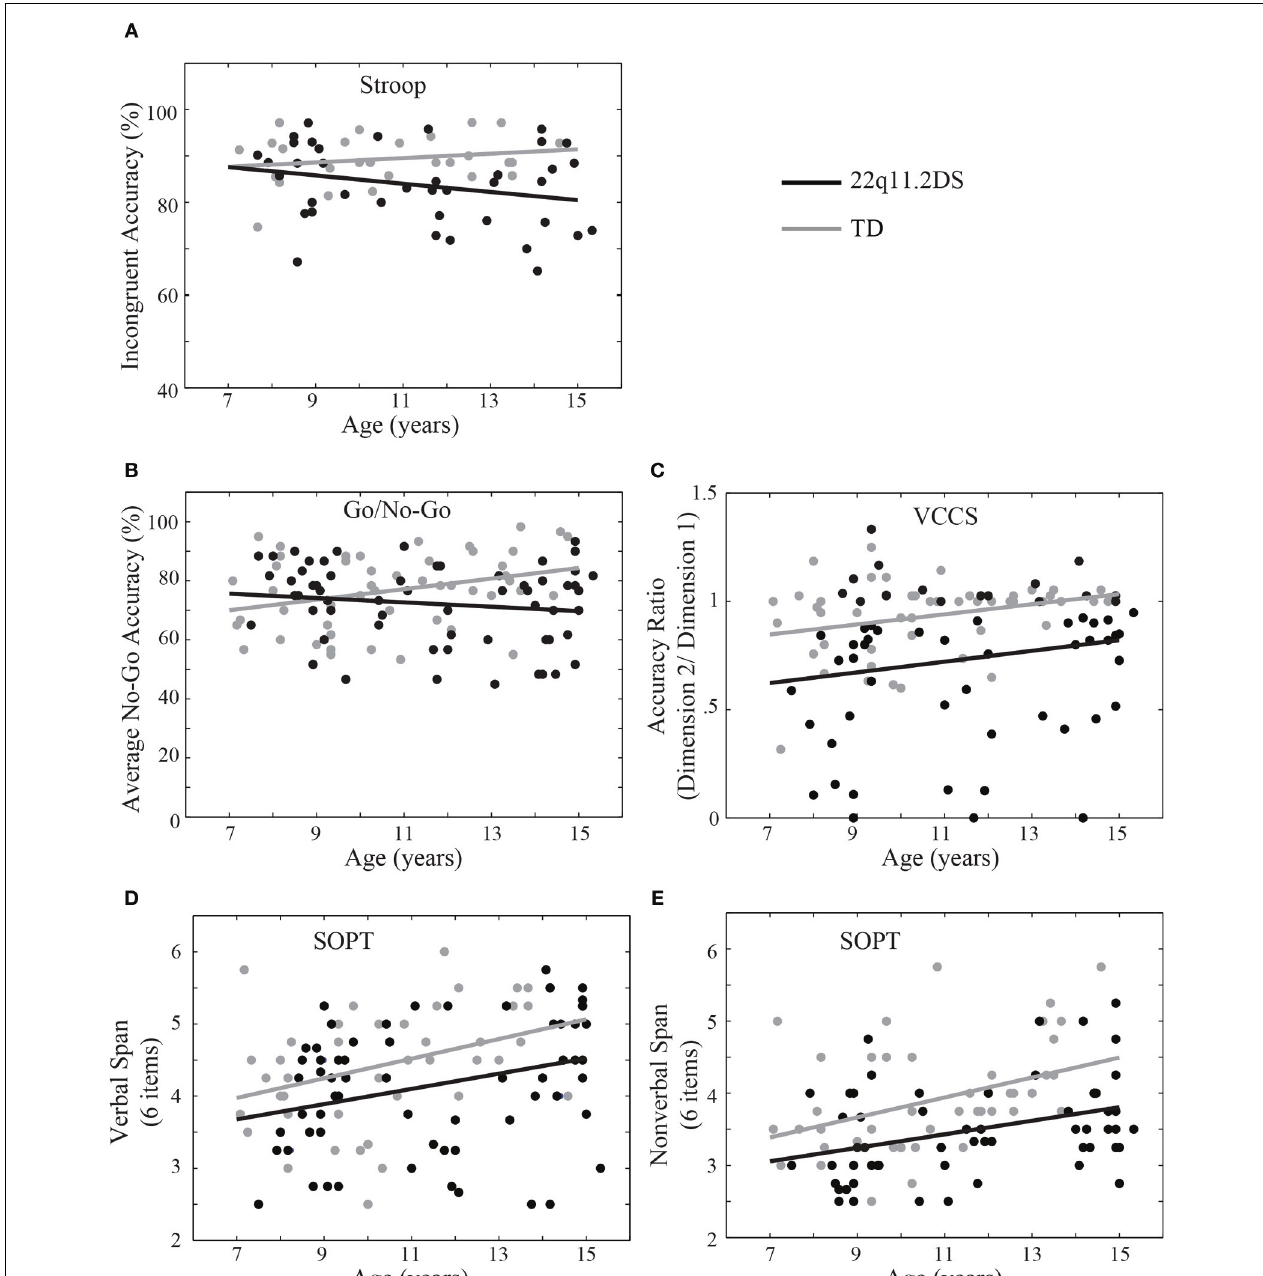
FIGURE 6 | Age-related associations with cognitive control component processes. Age was not related to incongruent accuracy on the Stroop for either group (A) . On the Go/No-Go task, TD children demonstrated a significant age-related association with No-Go accuracy ( p < 0 . 05) while children with 22q11.2DS did not (B) . Similarly, on the Visually-Cued Card Sort